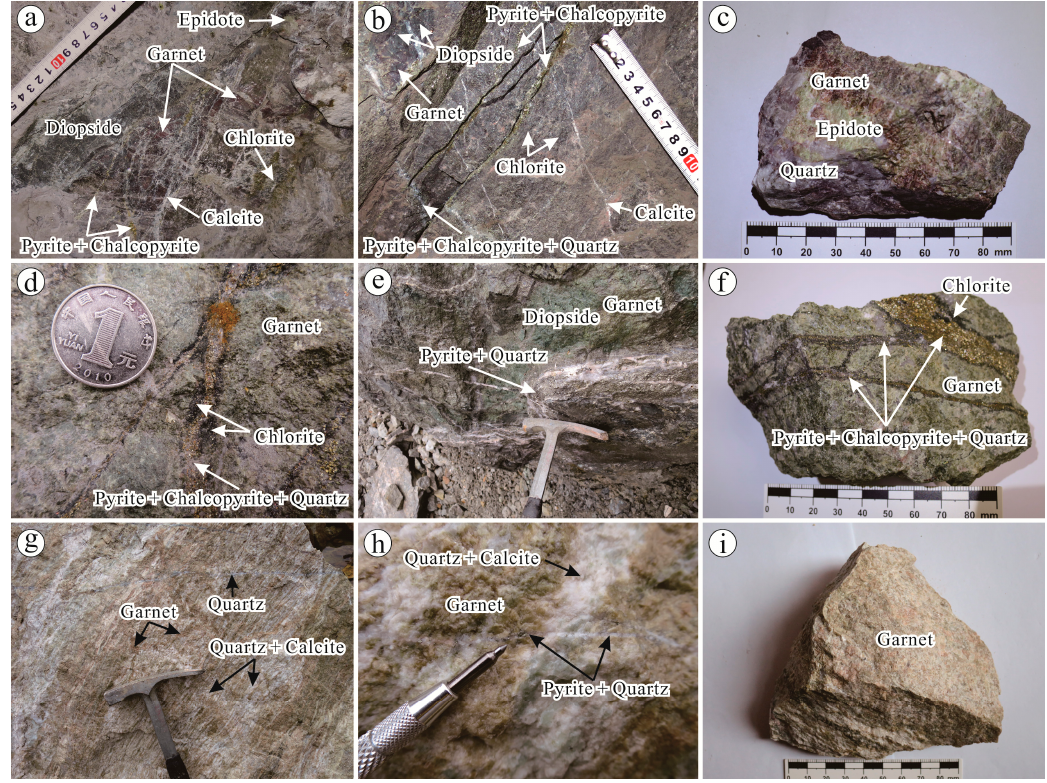
Figure 4. Photographs of Yongping garnet varieties. See text for additional explanation.